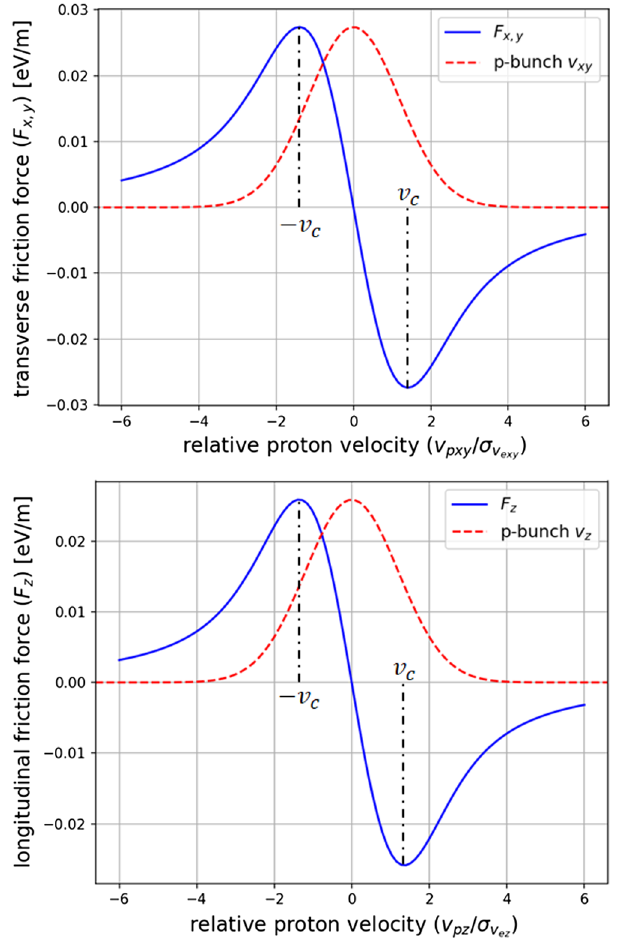
10. Transverse and longitudinal components of the friction force in the EIC precooler (solid blue line). Respective velocity distributions of protons are shown for comparison (red dashed line). The values of critical velocity mismatches are marked by v c .